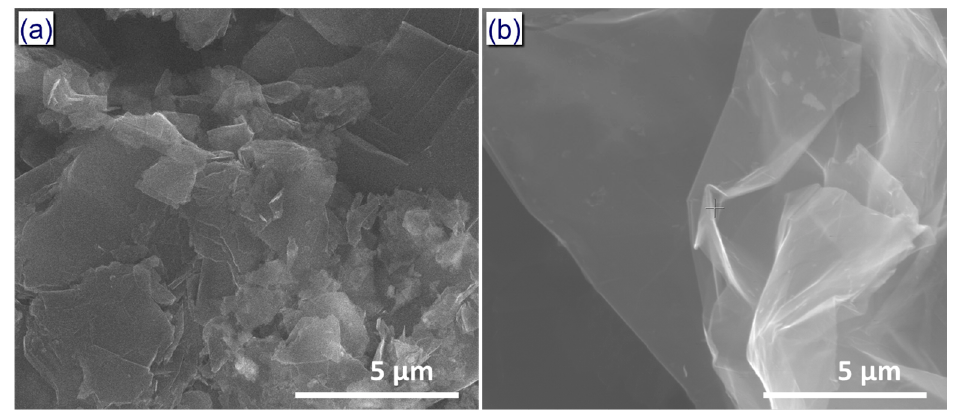
Figure 2. Scanning electron microscopy (SEM) images of ( a ) natural graphite and ( b ) graphene nanoplatelets (GNPs).